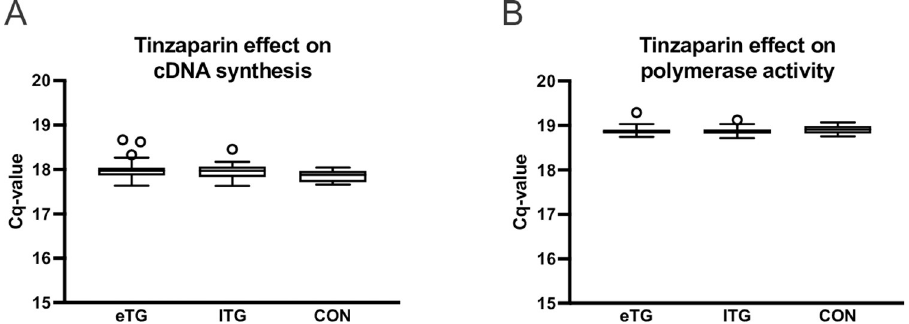
Fig 2. Effect of prophylactic tinzaparin treatment on cDNA synthesis and qPCR. Cq values for two synthetic spike- in RNAs, A) UniSp6 added to RNA prior to cDNA synthesis and B) UniSp3 added to cDNA prior to qPCR; UniSp6, ETG n = 71, LTG n = 58, CON n = 14; UniSp3, ETG n = 71, LTG n = 58, CON n = 14. ETG = early tinzaparin group, LTG = late tinzaparin group, CON = control. The horizontal line shows the median, while the box encompasses the 50th percentile and the whiskers encompass the minimum and maximum values. Outliers are displayed as points. Outliers are defined according to Tukey, as values exceeding more than the 75 percentile plus 1.5 IQR.